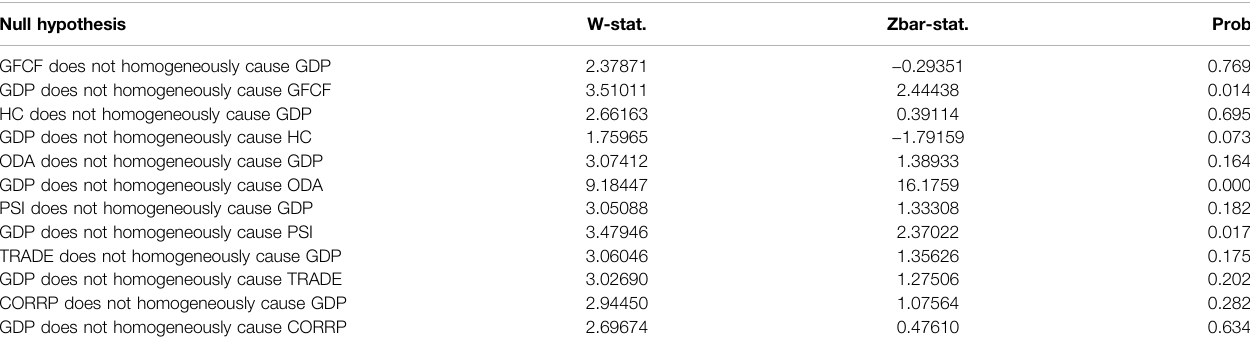
TABLE 10 | Results of pair-wise Granger Causality tests between variables and